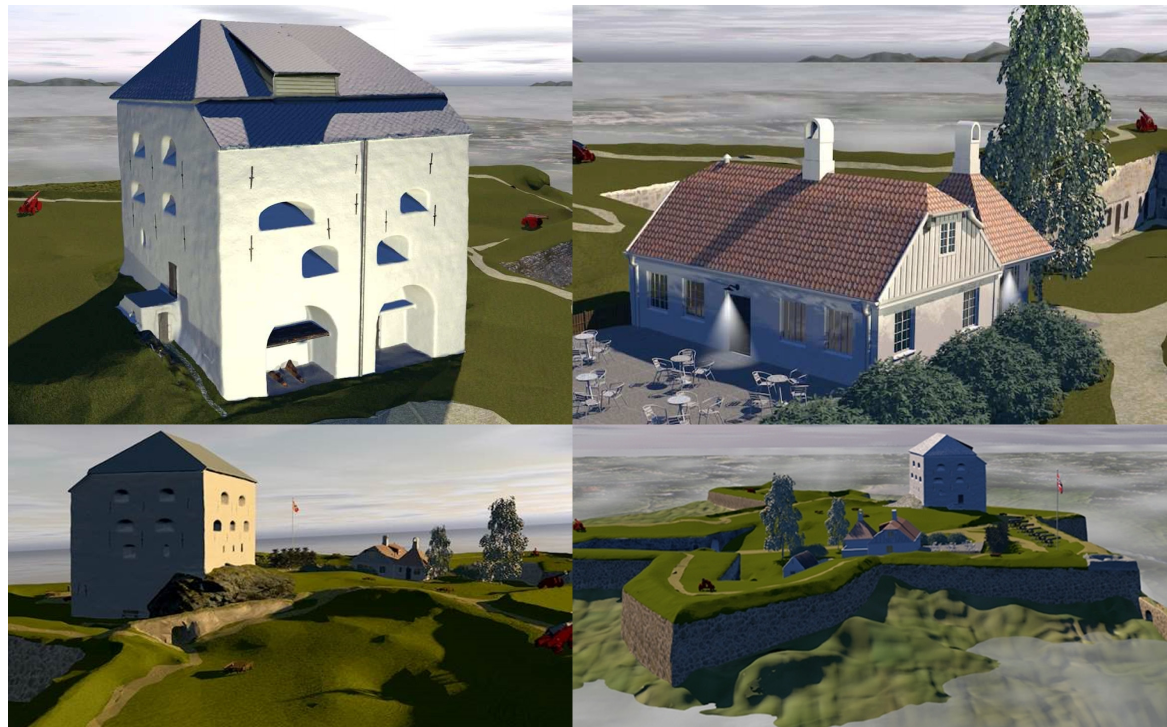
Figure 6: Cut-outs from the video of the fortress Kristiansten compiled in Cinema 4D – defence tower Donjon (top left) and commandant's office (top right) with lighting as well as perspective views on the entire fortress